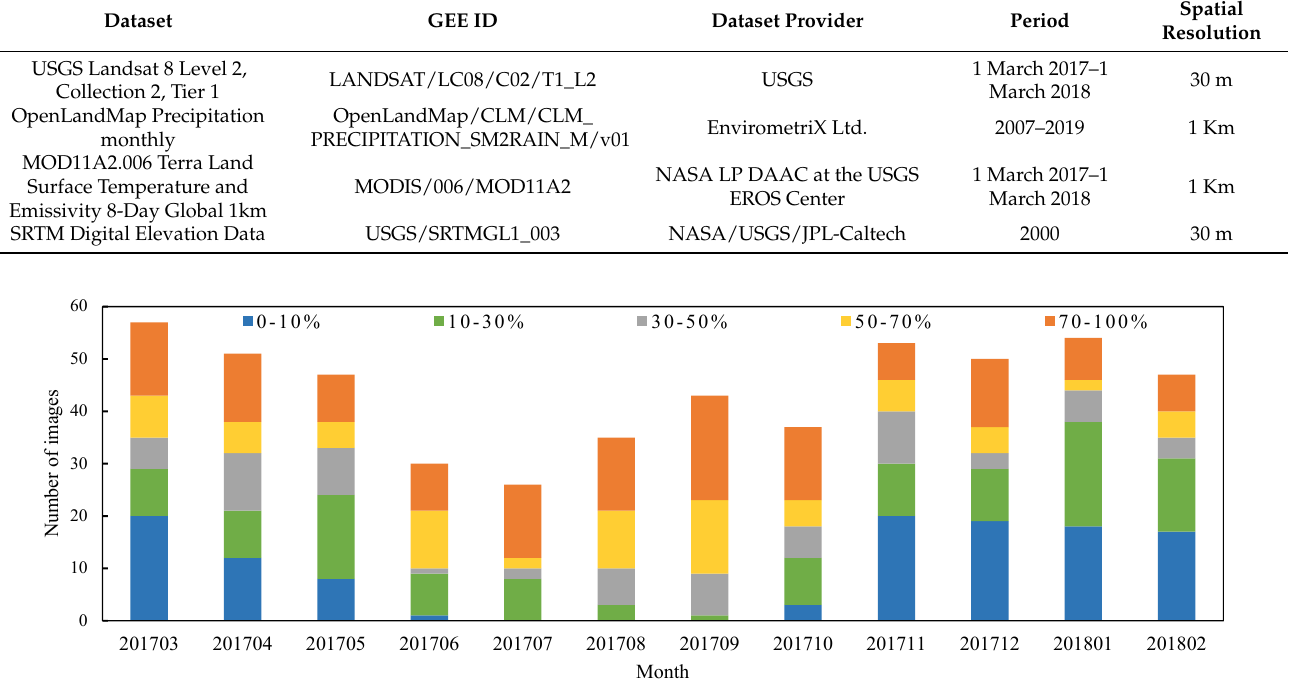
Figure 2. The number of collected Landsat 8 surface reflectance images in 12 months with five cloud cover percent levels. Spring is from April to May; Summer is from June to August; Autumn is from September to November; Winter is from December to February of next year (Spring: 155, Summer: 91, Autumn: 133, Winter: 151).